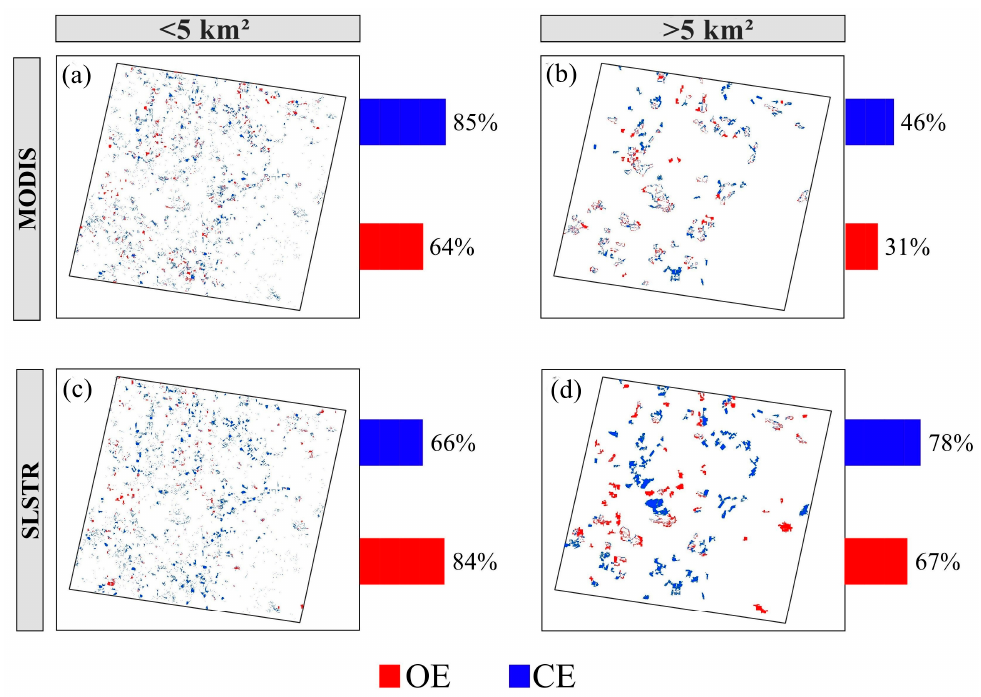
Figure 8. Representation of OE and CE for small (<5 km 2 ) and large (>5 km 2 ) fires for SLSTR and MODIS in the year 2021. ( a ) and ( b ) for MODIS. ( c ) and ( d ) for SLSTR.